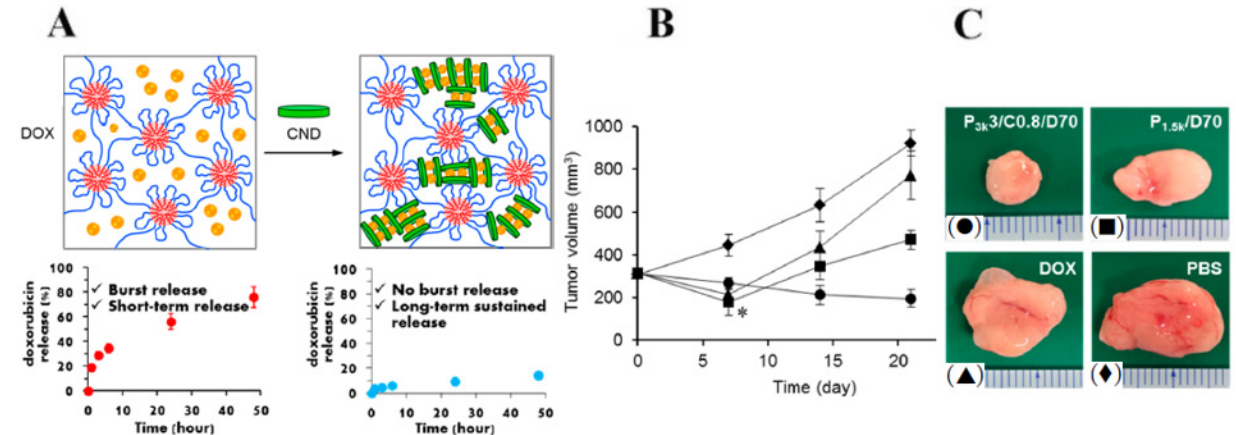
Figure 19. ( A ) Representation of PLGA-PEG-PLGA/DOX copolymer gel and PLGA-PEG- PLGA/CND/DOX hybrid gel. ( B ) In vivo antitumor activity of DOX-loaded hybrid gels against human cancer cells implanted in mice. PBS as control ( (cid:117) ); DOX solution ( (cid:78) ); P 1.5k /D70 gel ( (cid:4) ); and P 3k 3/C0.8/D70 gel (0.8 wt.% clay) ( • ) and ( C ) photographs of the excised tumors from animals sacrificed 21 days after injection. (Adapted with permission from [98]. Copyright 2015, American Chemical